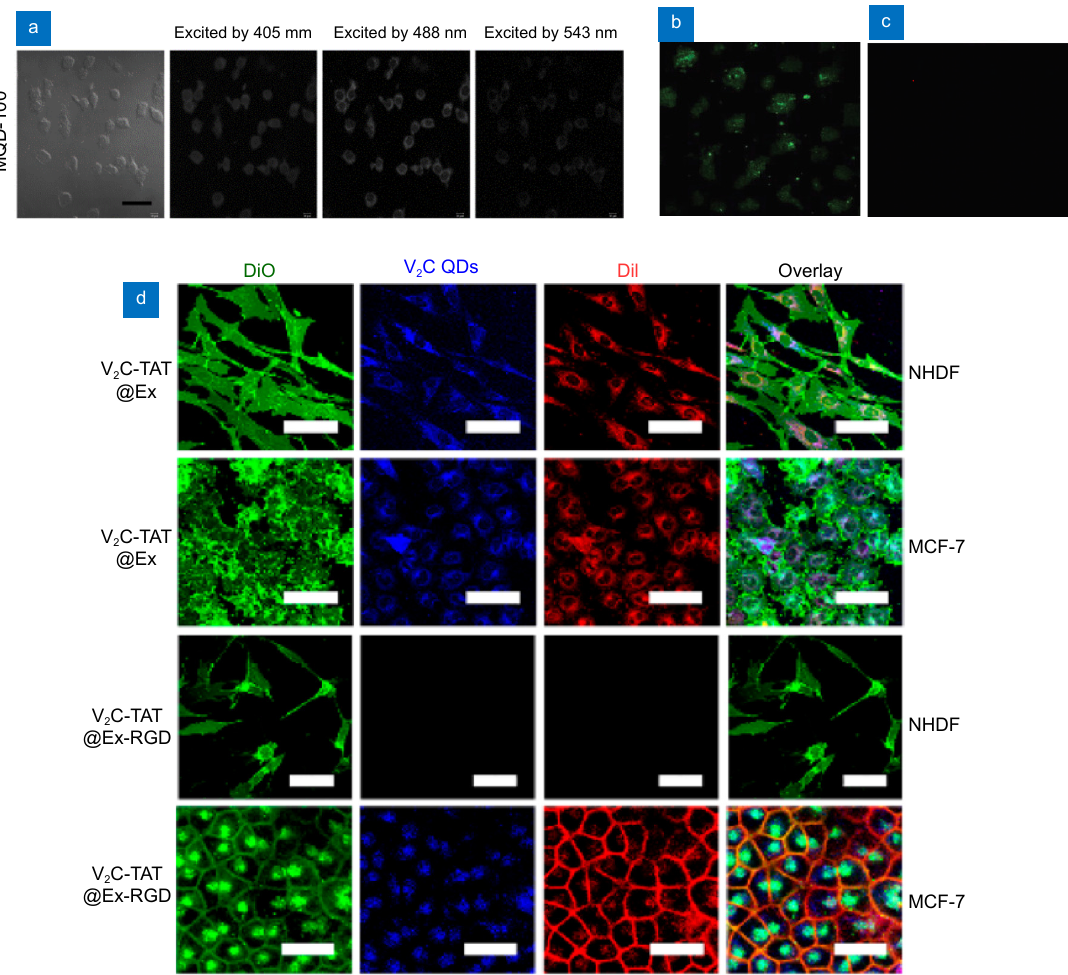
Fig. 11 | ( a ) Bright-field imaging of RAW264.7 cells and confocal imaging of RAW264.7 cells incubated with MQD-100 at 405 nm, 488 nm, and 543 nm excitation. ( b ),( c ) Fluorescent imaging (Ex = 488 nm) of the THP-1 monocytes incubated (b) with N,P-MQDs (c) without N,P-MQDs ( d ) CLSM images of MCF-7 and NHDF cells after incubation of V 2 C-TAT@Ex or V 2 C-TAT@Ex-RGD (Scale bar: 40 μm). The figures were repro- duced with permission from: (a) ref. 29 . Copyright 2017, John Wiley and Sons; (b),(c) ref. 110 . Copyright 2019, Royal Society of Chemistry; (d) ref. 68